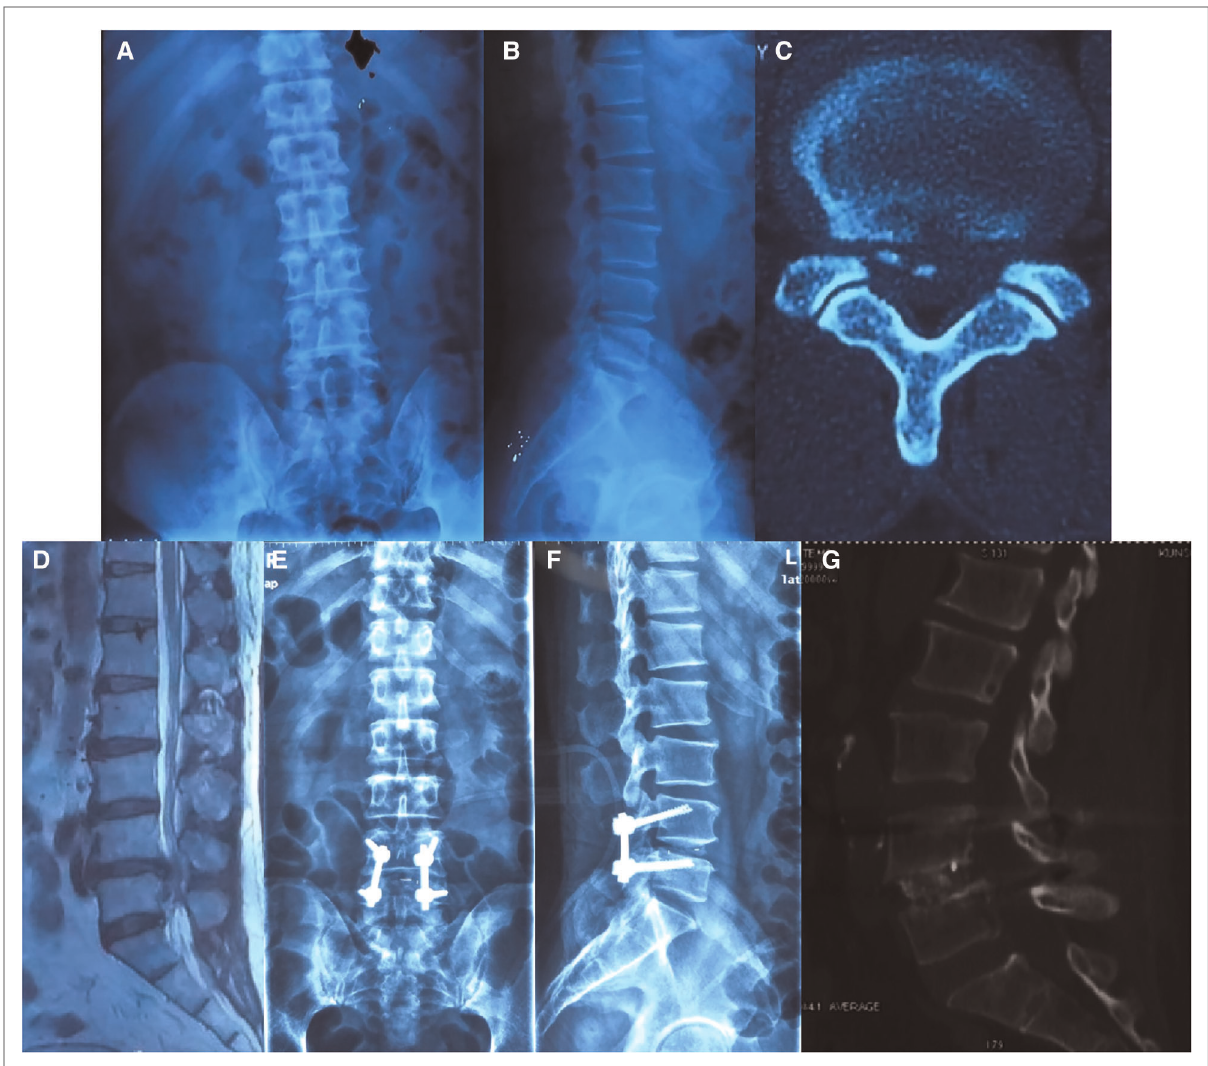
FIGURE 3 A sixty-one year old male patient, presented with low back pain radiating to both lower limbs, and had numbness of both lower limbs for 4 months. The pain and numbness were exacerbated and intermittent claudication existed for almost 2 months. Decreased muscle power for both iliopsoas, quadriceps femoris, semitendinosus, tibialis anterior, and triceps surae (Manual Muscle Test grade IV). The straight leg raising test of the left leg was positive (60°). Eaten( − ), Spurling( − ). MRI revealed a herniation disc at L4/L5 level. Postoperative x-ray showed perfect bone fusion and no internal fi xation was a failure. ( A,B ) Preoperative anteroposterior x-ray; ( C,D ) preoperative MRI of L4/L5; ( E,F ) anteroposterior and sagittal x-ray of the lumbar spine 2 years after surgery. ( H ) Postoperative sagittal